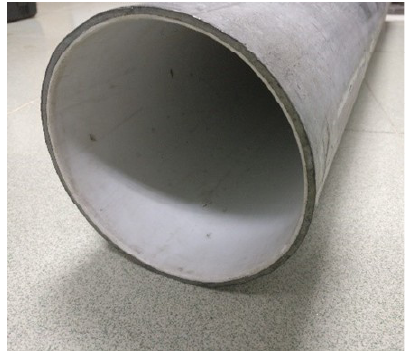
Figure 6. Side view of the anti-corrosive pipe.